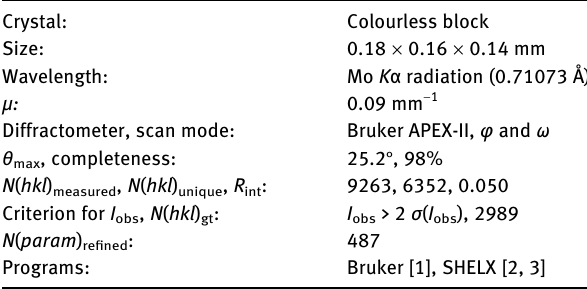
Table  : Data collection and